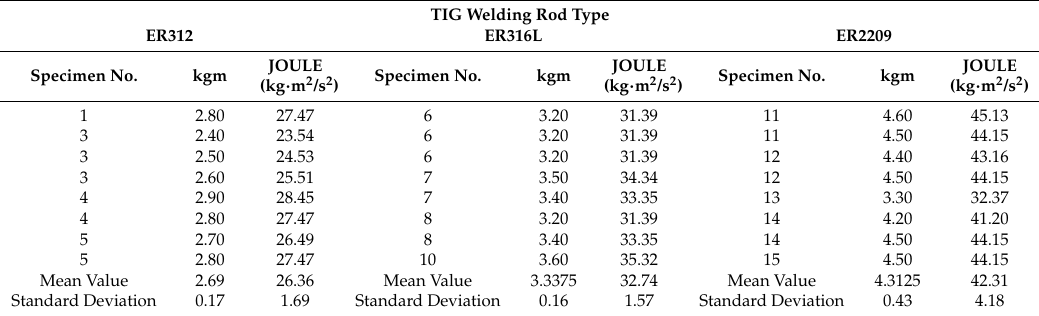
Table 6. Charpy impact energy values of welded